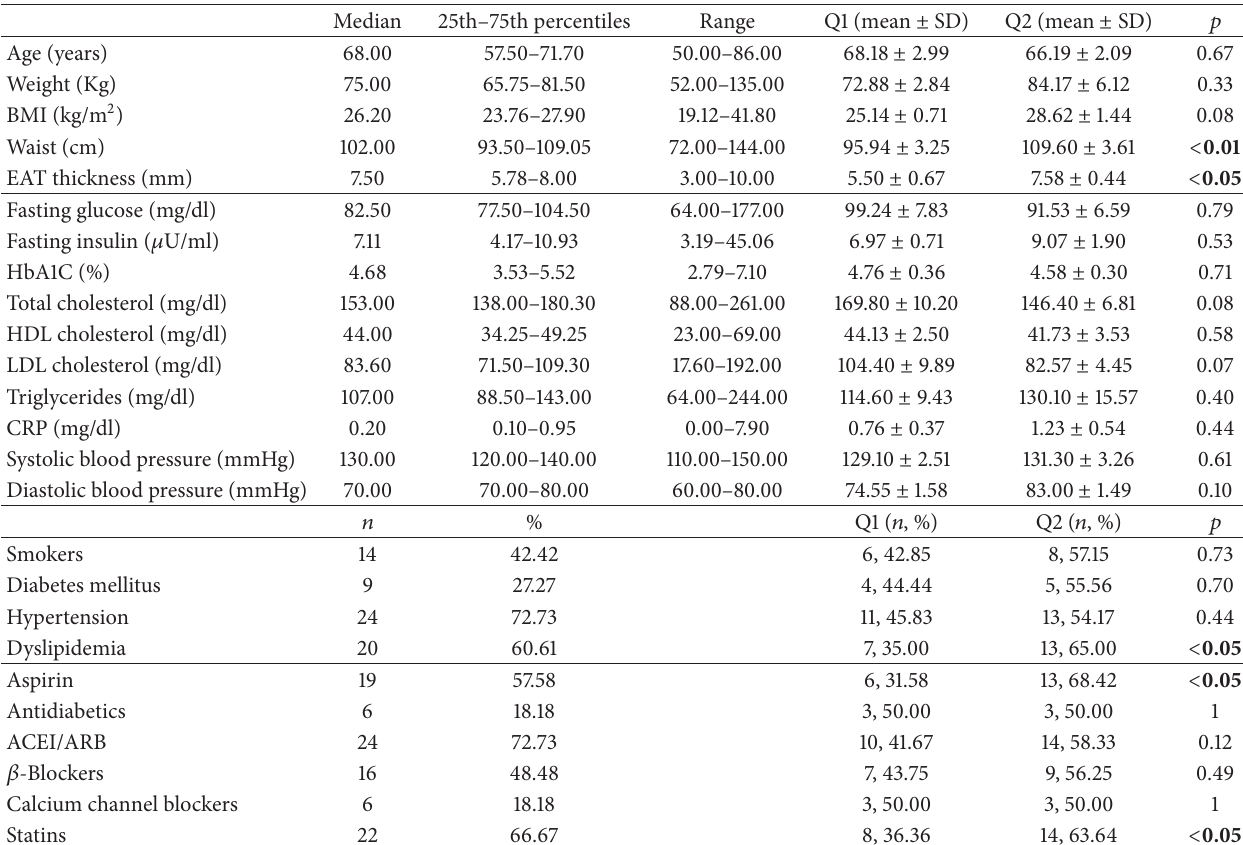
Table 1: Demographic, anthropometric, and biochemical characteristics of coronary artery disease patients included in the study before and after classification according to the median value of RAGE expression at EAT level (Q1 and Q2